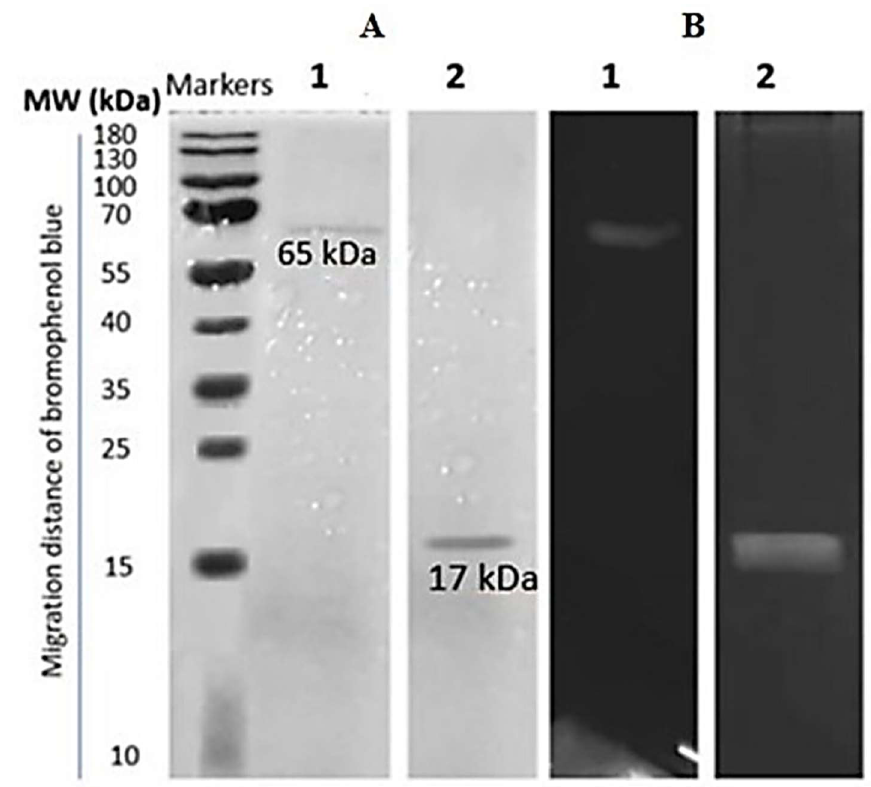
Figure 5. The 12% SDS-PAGE gel ( A ) and zymogram analysis ( B ) of partially purified protease from B. sp. Lane 1: B. subtilis strain S1 and Lane 2: B. amyloliquefaciens strain KSM12.